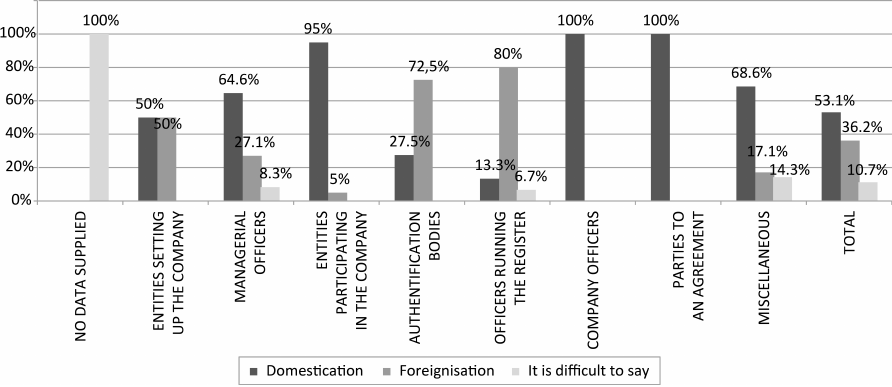
Figure 2. Distribution of the translation strategies in relation to the categories